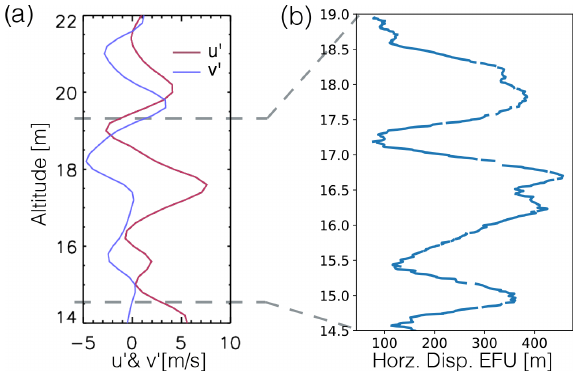
Figure 7. (a) Meridional and zonal wind perturbations as a function of altitude from radiosonde observations in Riverton, WY. (b) Hor- izontal displacement of FLOATS EFU as function of gondola alti- tude.